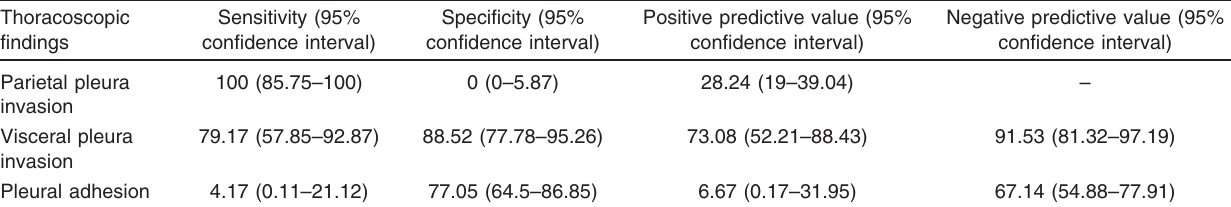
Table 4 Sensitivity, specificity, positive and negative predictive values of thoracoscopic findings in relation to positive pleural fluid cytology Thoracoscopic findings